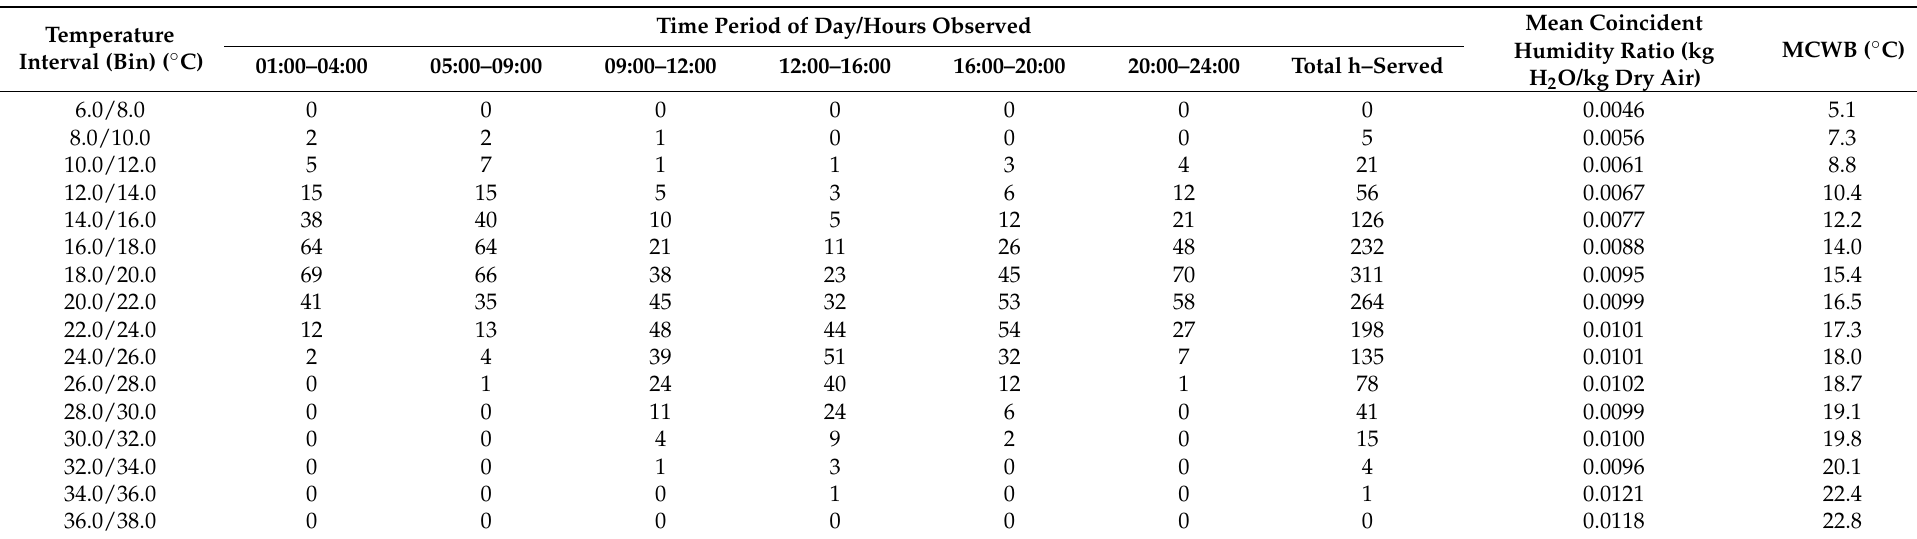
Table 4. Bin data for Athens (NOA). Transitional months (May and October)—Period